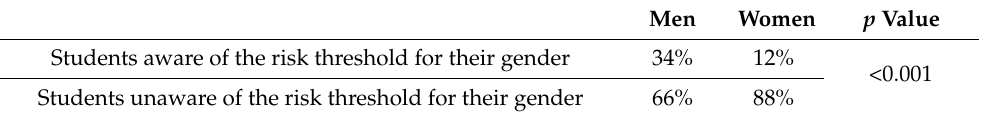
Table 4. Percentages of students aware of the risk threshold of alcohol consumption for their